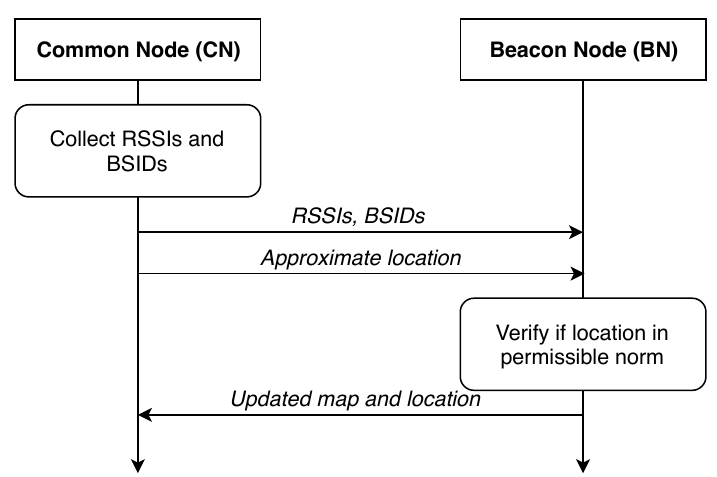
Figure 2. An illustration of communication between common and beacon nodes.